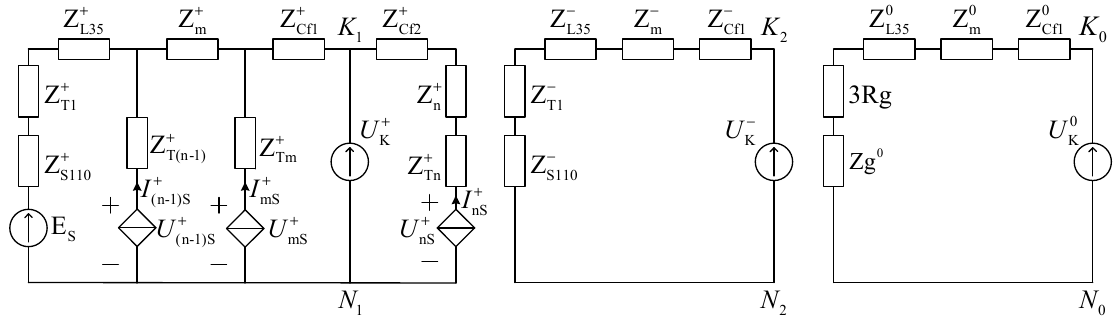
Figure 5. Fault sequence network for the fault on the collector line.